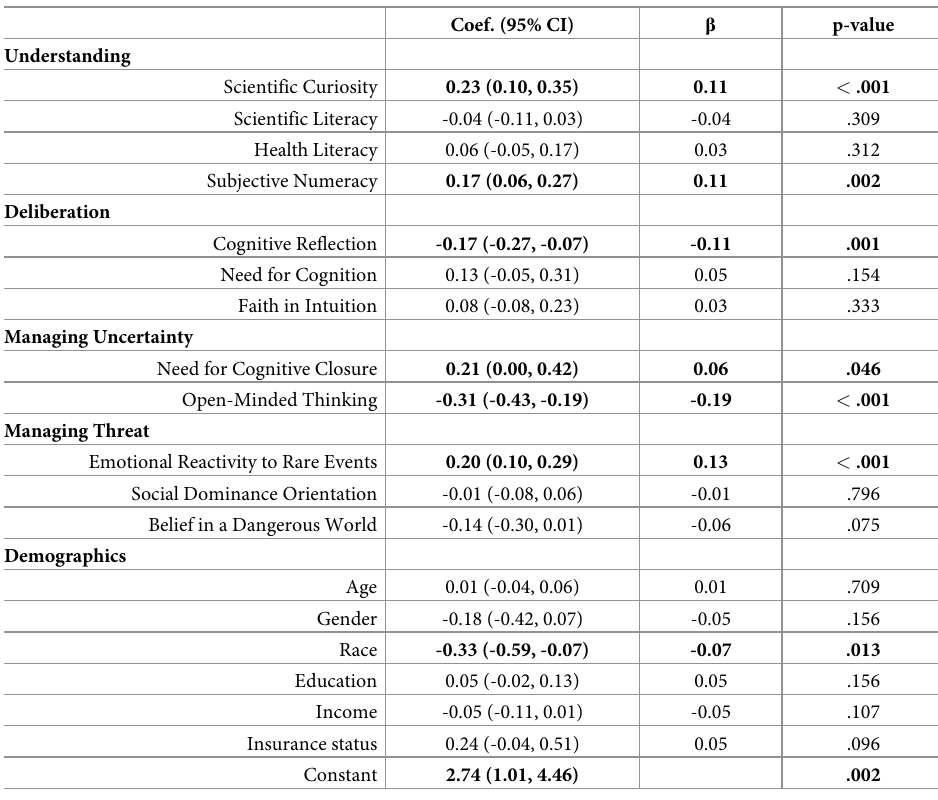
Table 5. Linear regression results for HPV vaccination intentions (N =